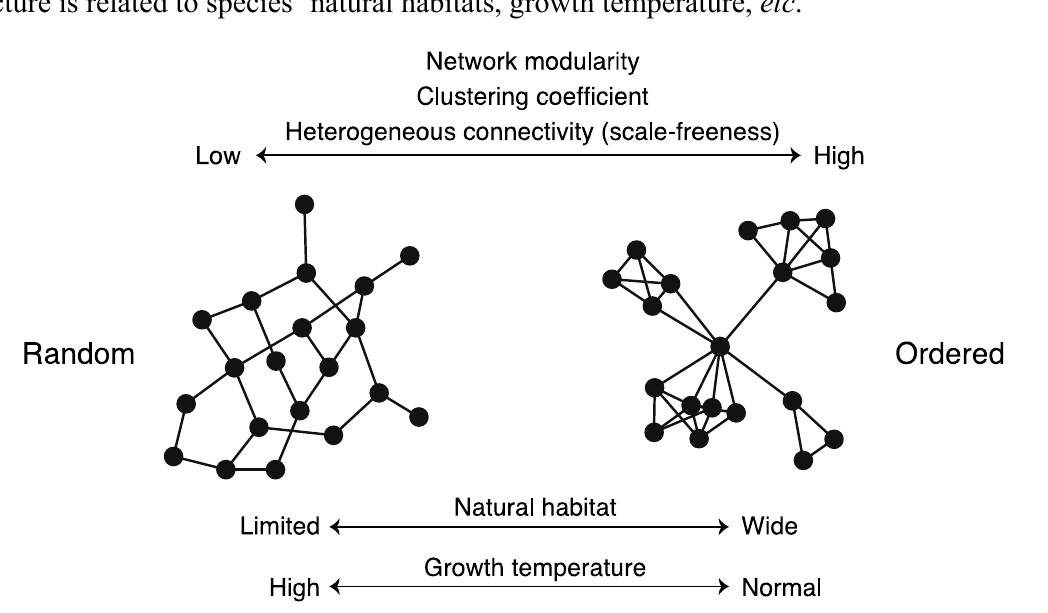
Figure 8. Schematic diagram of structural properties of metabolic networks. Network structure is related to species’ natural habitats, growth temperature, etc